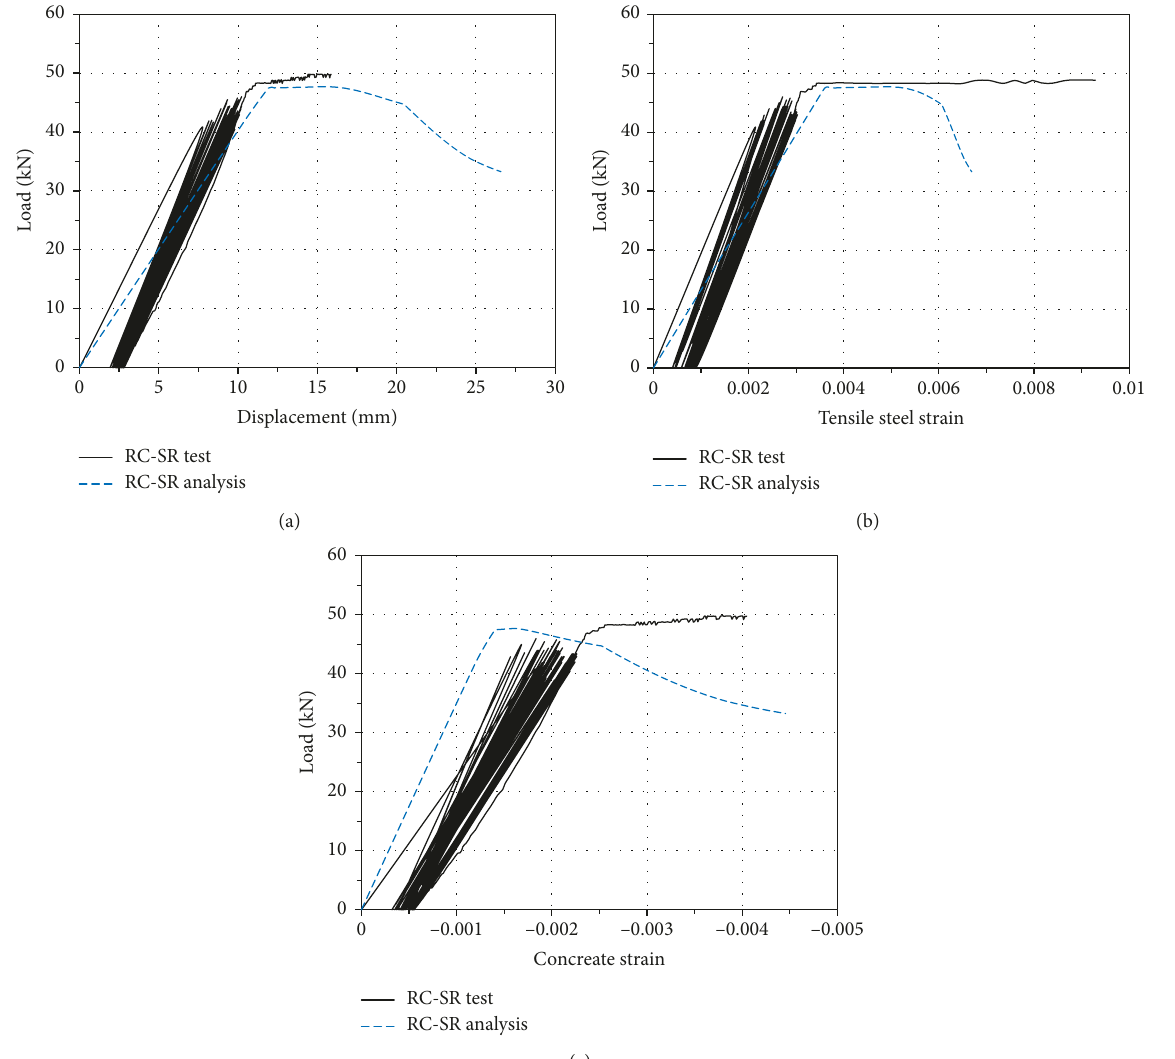
Figure 14: Comparison of predicted and experimental fatigue test results of RC-SR: (a) fatigue load-deflection curves at midspan of RC-SR; (b) fatigue load-tensile strain curves in longitudinal reinforcement of RC-SR; (c) fatigue load-concrete compressive strain curves of